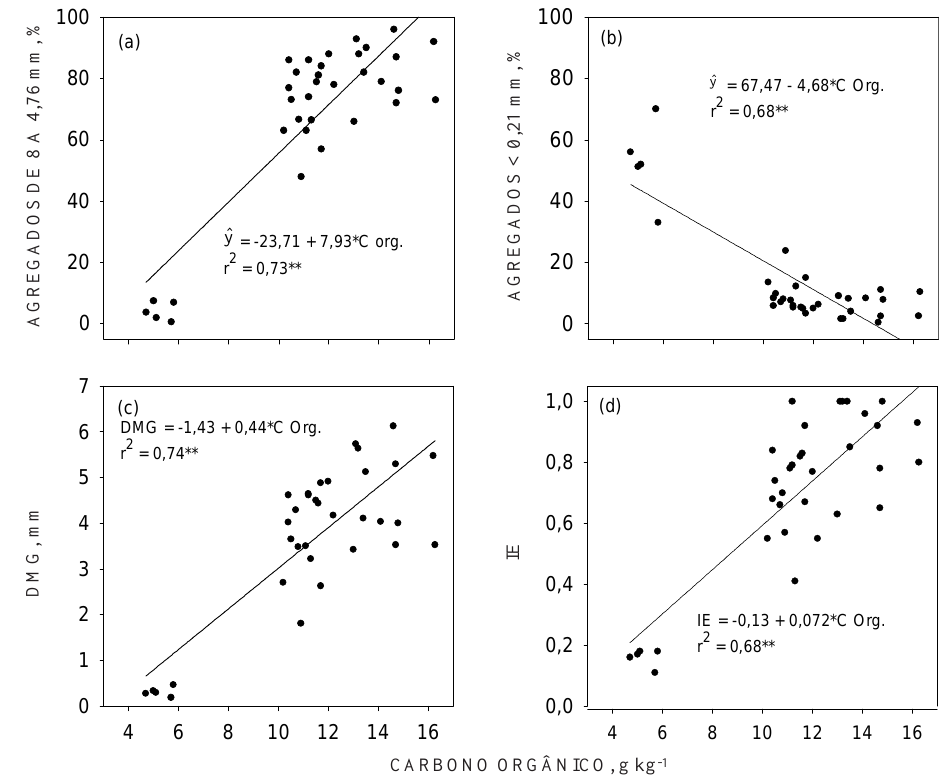
Figura 3. Relação entre agregados da classe de 8,00 a 4,76 mm, agregados menores que 0,21 mm, diâmetro médio geométrico padrão (DMGp) e índice de estabilidade de agregados (IE) com o teor de carbono orgânico do